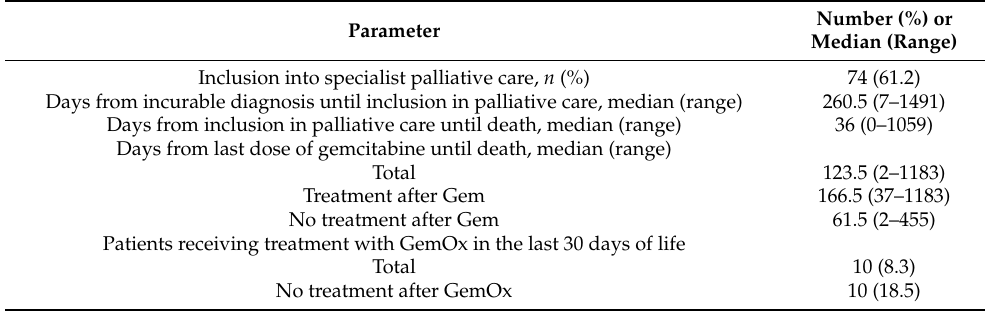
Number (%) or Median (Range)